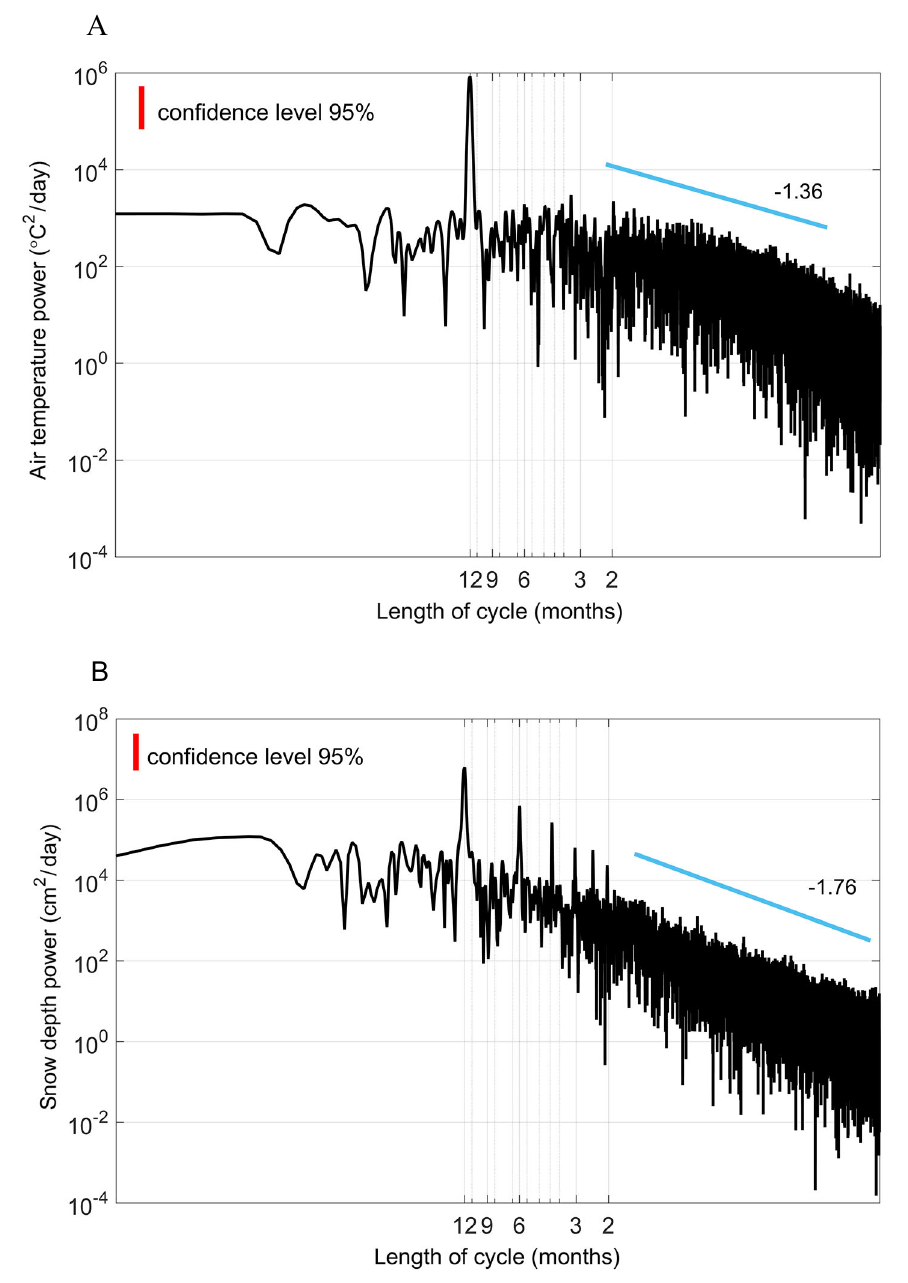
Fig. 6. Power spectrum of air temperature (A) and snow depth (B) in Rovaniemi based on data from 1946 until